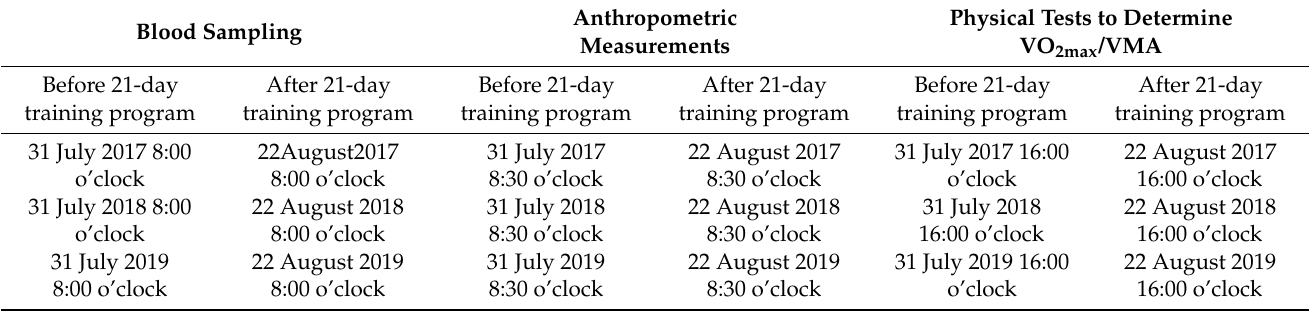
Table 1. Graph of